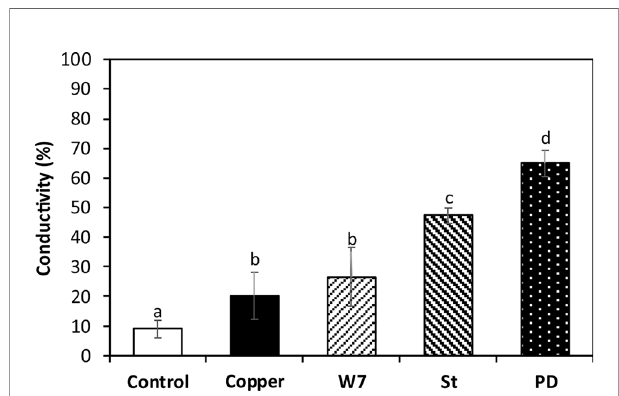
FIGURE 7 | Percentage of ion leakage in U. compressa cultivated in seawater without copper addition (white bar), with 10 µM of copper (black bar), with 100 µM of W-7, 10 µM of staurosporine (St), 5 µM of PD-98059 (PD) and with copper for 5 days (hashed bars). Percentage of ion leakage is obtained considering 100% ion leakage in obtained in the alga subjected to heating at 120°C for 20 min. Bar represent mean values of three independent experiments. Different letters indicate signi fi cant differences among mean values (±SD) ( P <